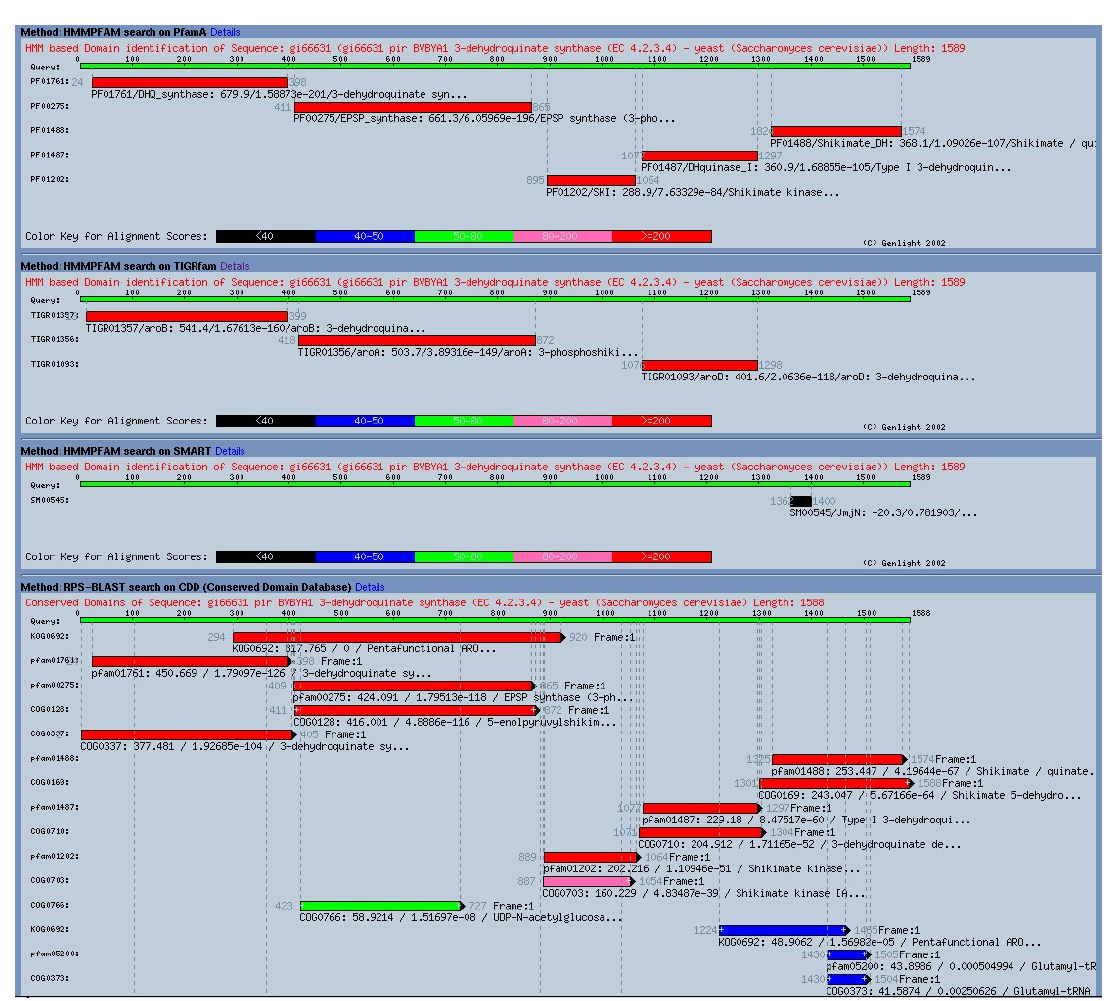
Figure 3: The web based User Interface: Visualization of the results of conserved motif screen- ings in different databases for the 3-dehydroquinate synthase of S. cerevisiae , a typical multi domain